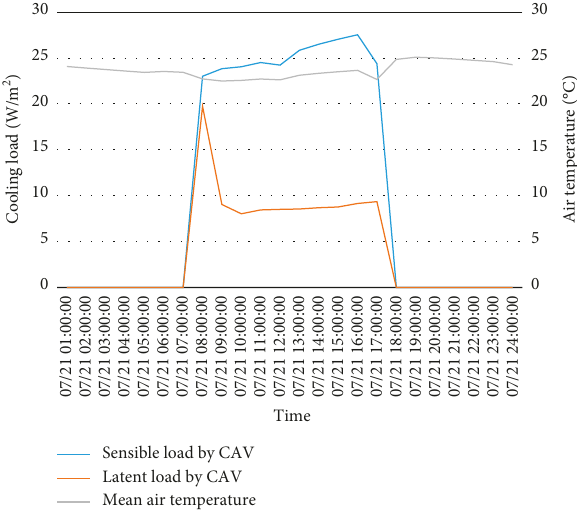
Sensible load by CAV Latent load by CAV Figure 9: Sensible and latent load removed by CAV.